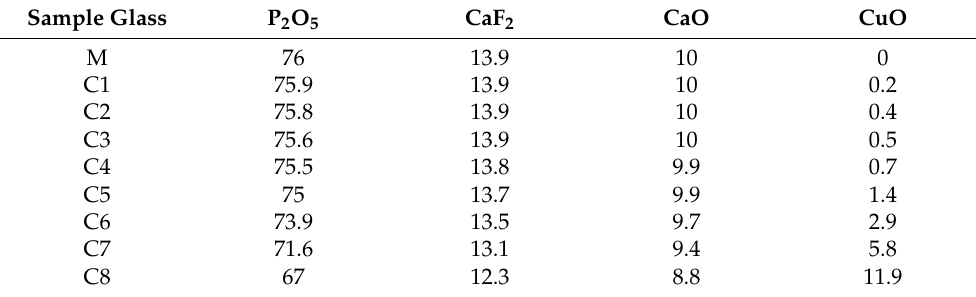
Table 1. Chemical compositions (wt%) of CaO-P2O5-CaF:CuO glasses. Sample